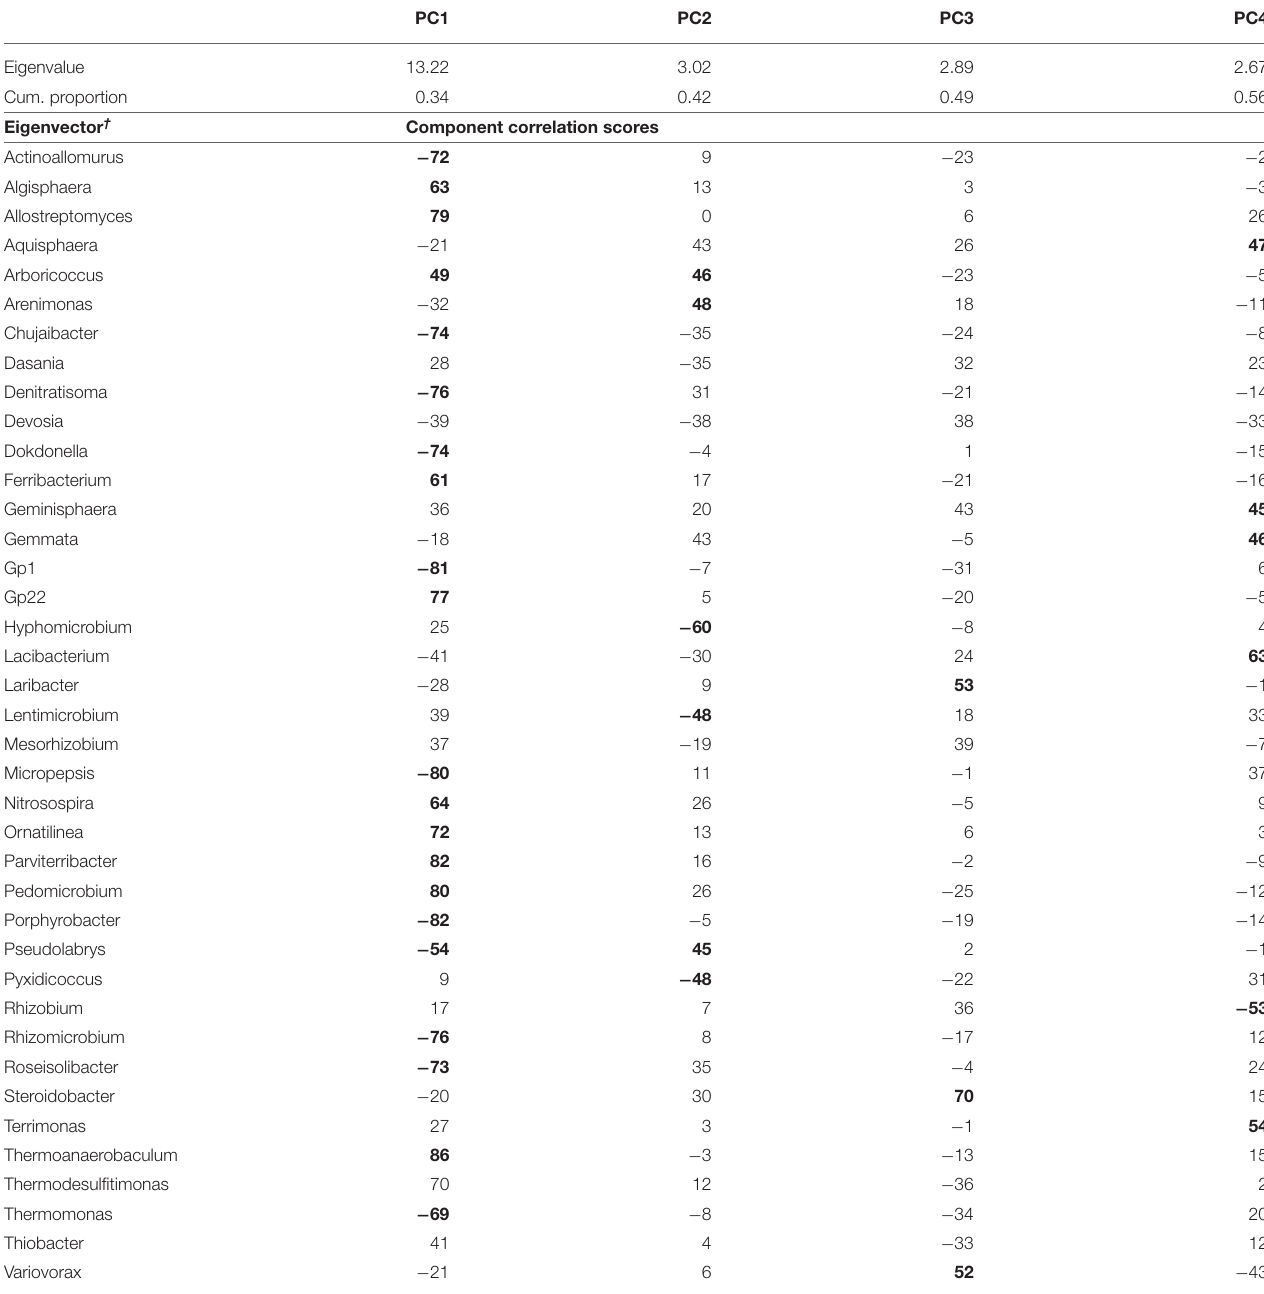
TABLE 3 | Results of the principal component analysis of bacteria genera showing the eigenvalues, the cumulative proportion of variability explained, and the eigenvectors for each of the four principal components (PC) extracted. PC1 PC2 Eigenvalue Cum.